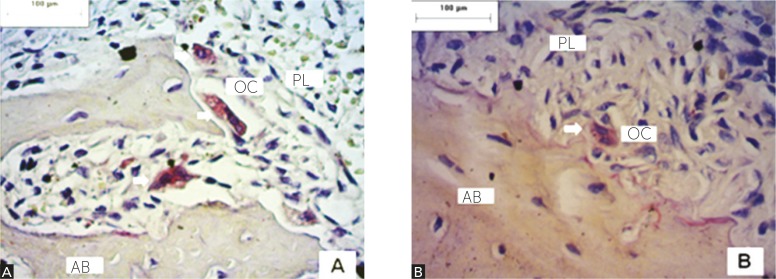
Photomicrographs of histological slides in CG (A) and EG (B) on the 28th
day after orthodontic appliance installation. Fewer osteoclasts were observed
in the EG on the side where pressure was applied to the periodontal ligament of
the mesiobuccal root of the right maxillary first molar. AB: alveolar bone; PL:
periodontal ligament; OC: osteoclasts. White arrows indicate A B TRAP-positive
cells (TRAP, magnification 400x).